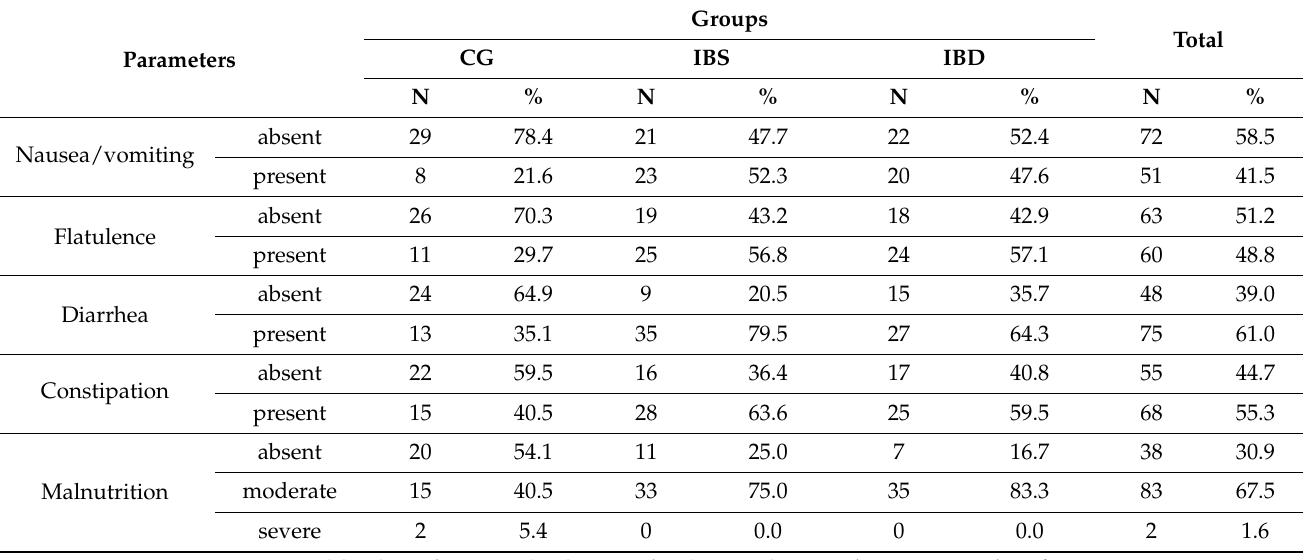
Table 4. Descriptive presentation of the parameters of gastrointestinal disorders in the three research